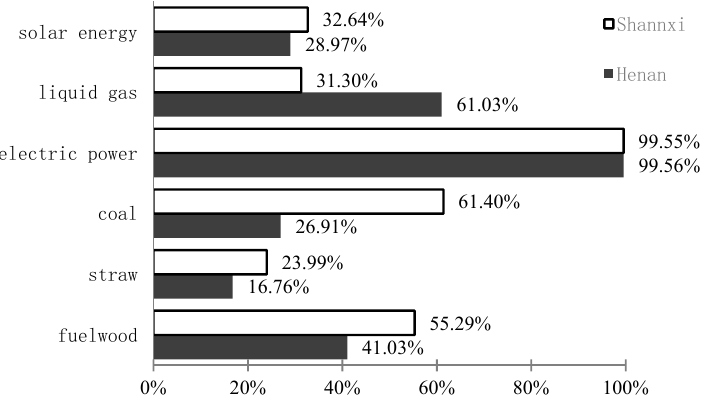
Figure 2. Proportion of energy consumption of rural households in Shaanxi and Henan provinces (N = 1351).